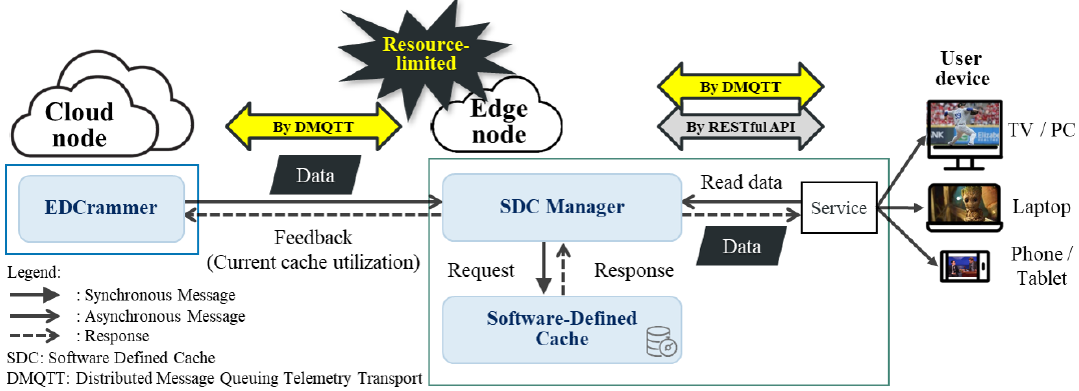
Figure 3. A communication diagram illustrating the interface between